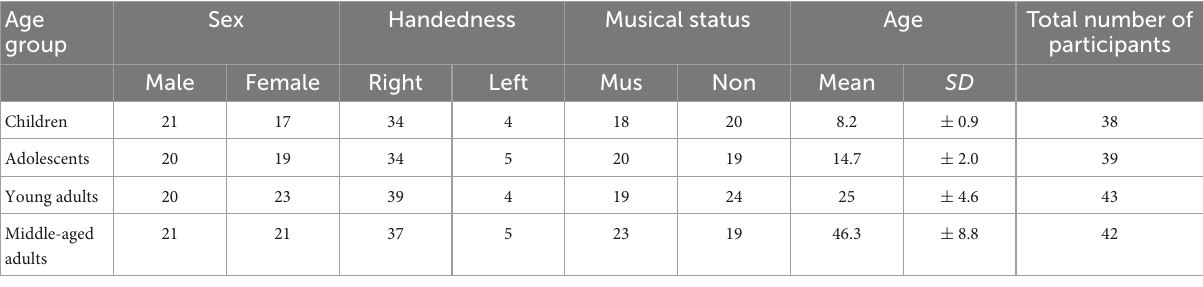
TABLE 2 Demographic data musicians vs. non-musicians. Age